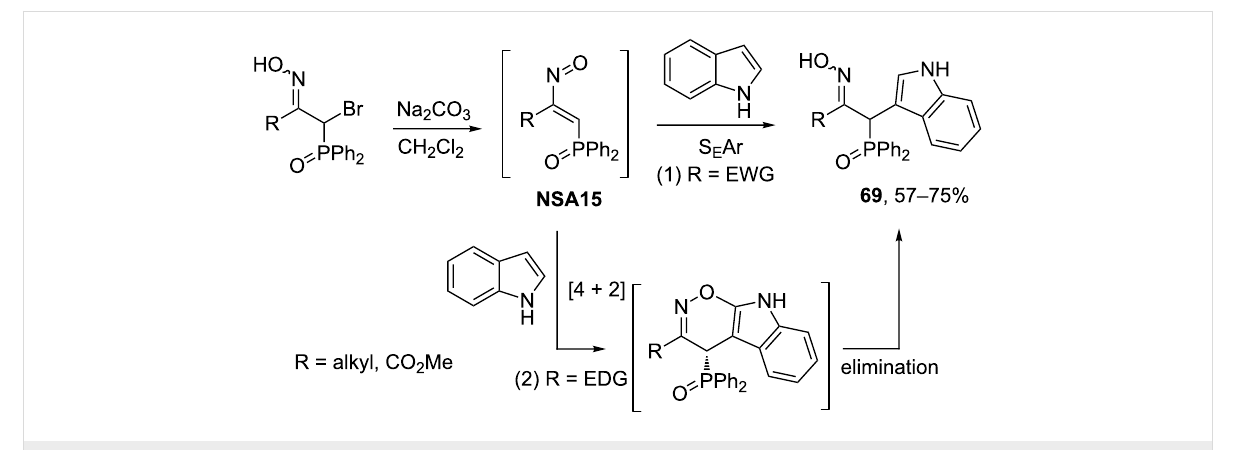
Scheme 24: Reaction of phosphinyl nitrosoalkenes NSA15 with